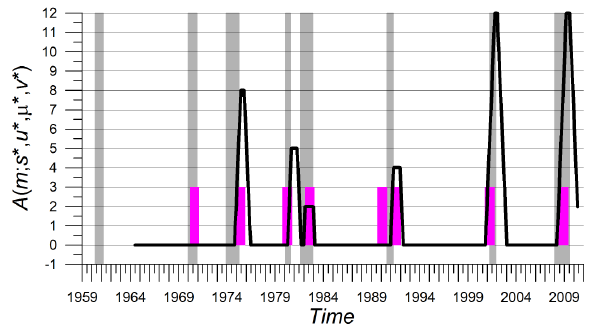
Fig. 17. Same as Fig. 16, but for the prediction of periods of fast acceleration of unemployment (FAU). Parameter values were calcu- lated from the FRBSL monthly series of the index of help wanted advertising (LHELL); they are the same as for the economic reces- sion prediction, except for µ ∗ = 1 . 0. Same conventions as in the previous figure. 104